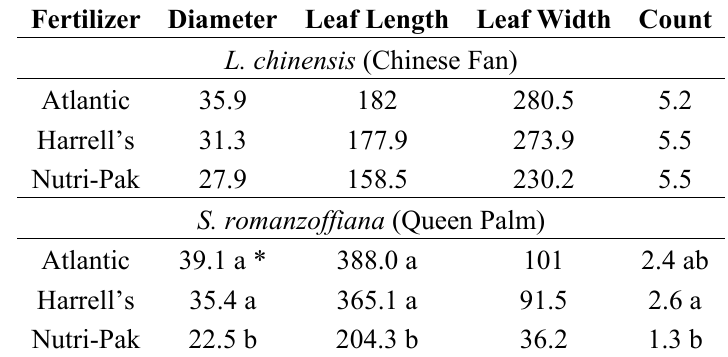
Figure 1. Mean diameter of Livistona chinensis ( a ) and Syagrus romanzoffiana ( b ) plants developed during 17 months of growth with either Atlantic, Harrell’s or Nutri-Pak fertilizer. Error bars represent the standard deviation of the means of the 10 replications for each fertilizer treatment. Plots were fit to a polynomial equation with the R 2 value given next to equation. Table 1. Difference in mean values for basal diameter (mm), leaf length (cm), leaf width (cm), and leaf count per plant between December 2013 and December 2014 for Livistona chinensis and Syagrus romanzoffiana plants fertilized with Atlantic, Harrell’s or Nutri-Pak